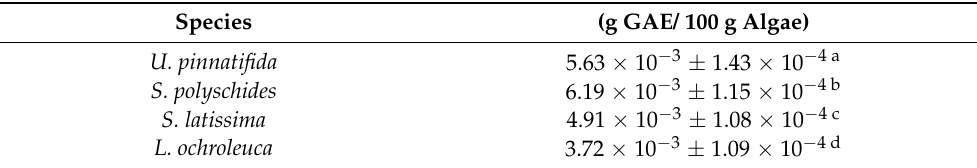
a,b,c,d Similar letters indicate no significant differences at the p- value < 0.05